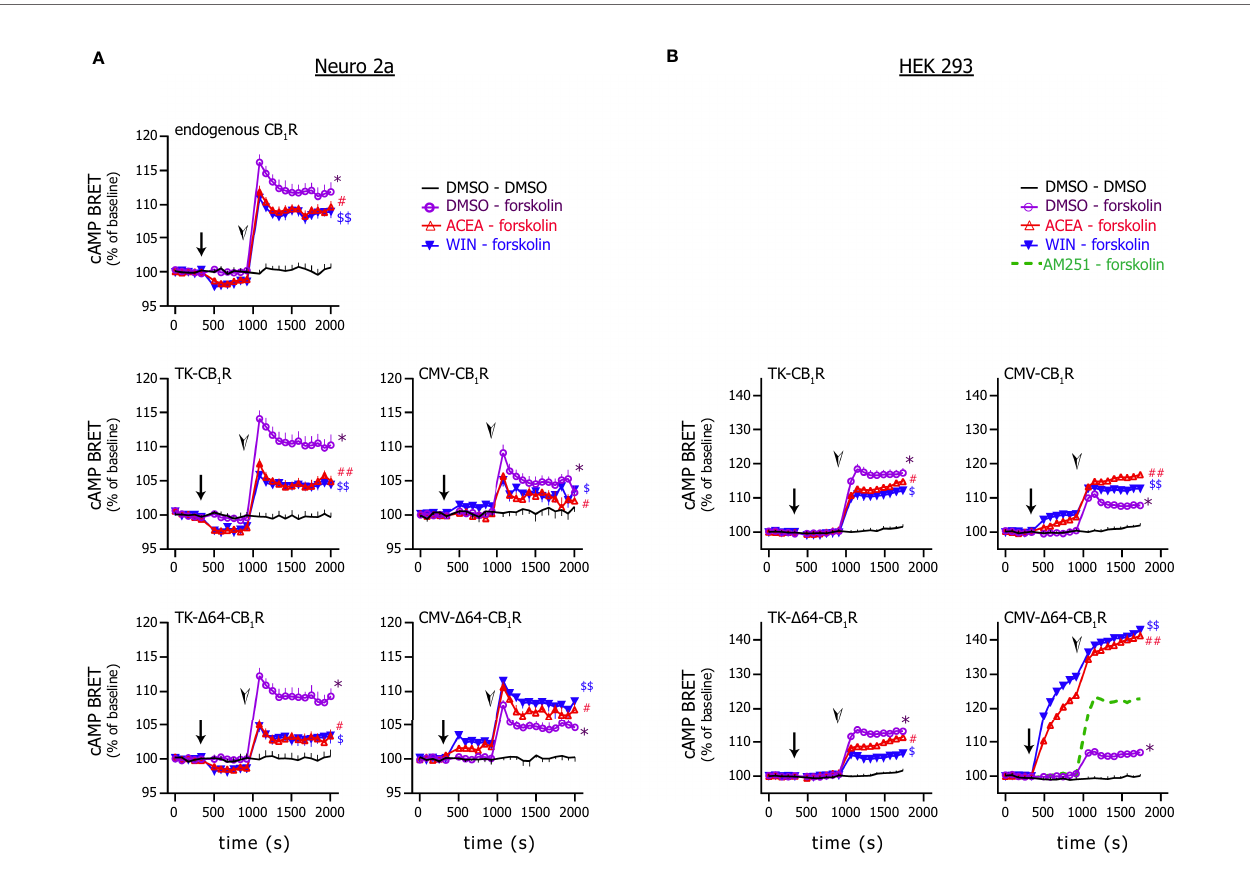
FIGURE 4 | Effect of CB 1 R stimulation on cytosolic cAMP. Neuro 2a (A) and HEK 293 (B) cells expressing the EPAC-based intramolecular cAMP sensor together with the indicated CB 1 R variant were stimulated fi rst with the CB 1 R agonists ACEA (20 µM) or WIN55,212-2 (1 µM) or vehicle (arrows) followed by the addition of forskolin (1 µM) or vehicle (arrowheads). BRET ratios were normalized to the average measured during control period. (In one experiment, the effect of the CB 1 R inverse agonist AM251 (2 µM) was also tested instead of CB 1 R agonist; average of 3 wells are shown.) Number of observations was min. 8 wells from 3 independent experiments. In some cases, to aid perceptibility, mean + or – S.E.M are presented only; in some graphs, symbols are larger than error bars and thus the latter are not visible. Data were analysed with 2-way ANOVA in combination with Dunnett ’ s multiple comparisons test. Symbols represent signi fi cances as follows: *: signi fi cant difference (p < 0.0001) vs . DMSO-DMSO detected after the addition of forskolin; # and $: signi fi cant difference (p < 0.0001) vs . DMSO-forskolin detected after the addition of forskolin; ## and $$: signi fi cant difference (p < 0.05) vs . DMSO-forskolin detected already after the addition of the CB 1 R agonist and before forskolin stimulation and signi fi cance increased (p < 0.0001) after the addition of